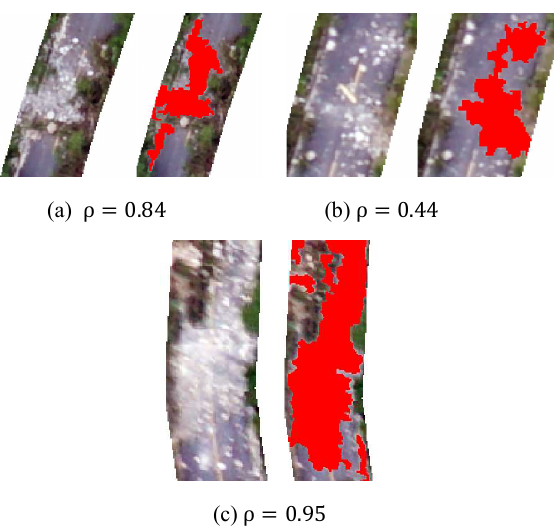
Figure 10. Road Accessibility